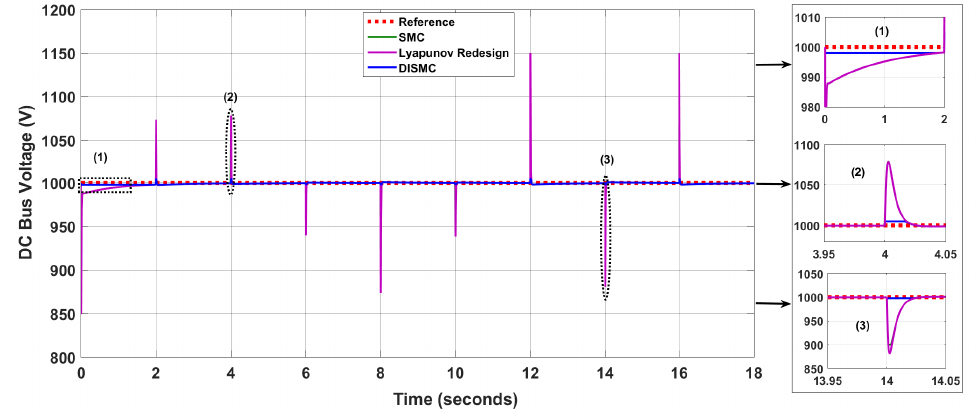
Figure 9. Voltage Regulation at DC Bus x 5 (case-I).